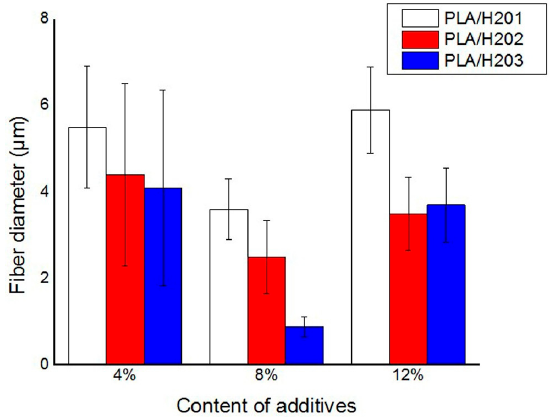
Figure 3. The relation between fiber diameter and the type and content of HBPs.